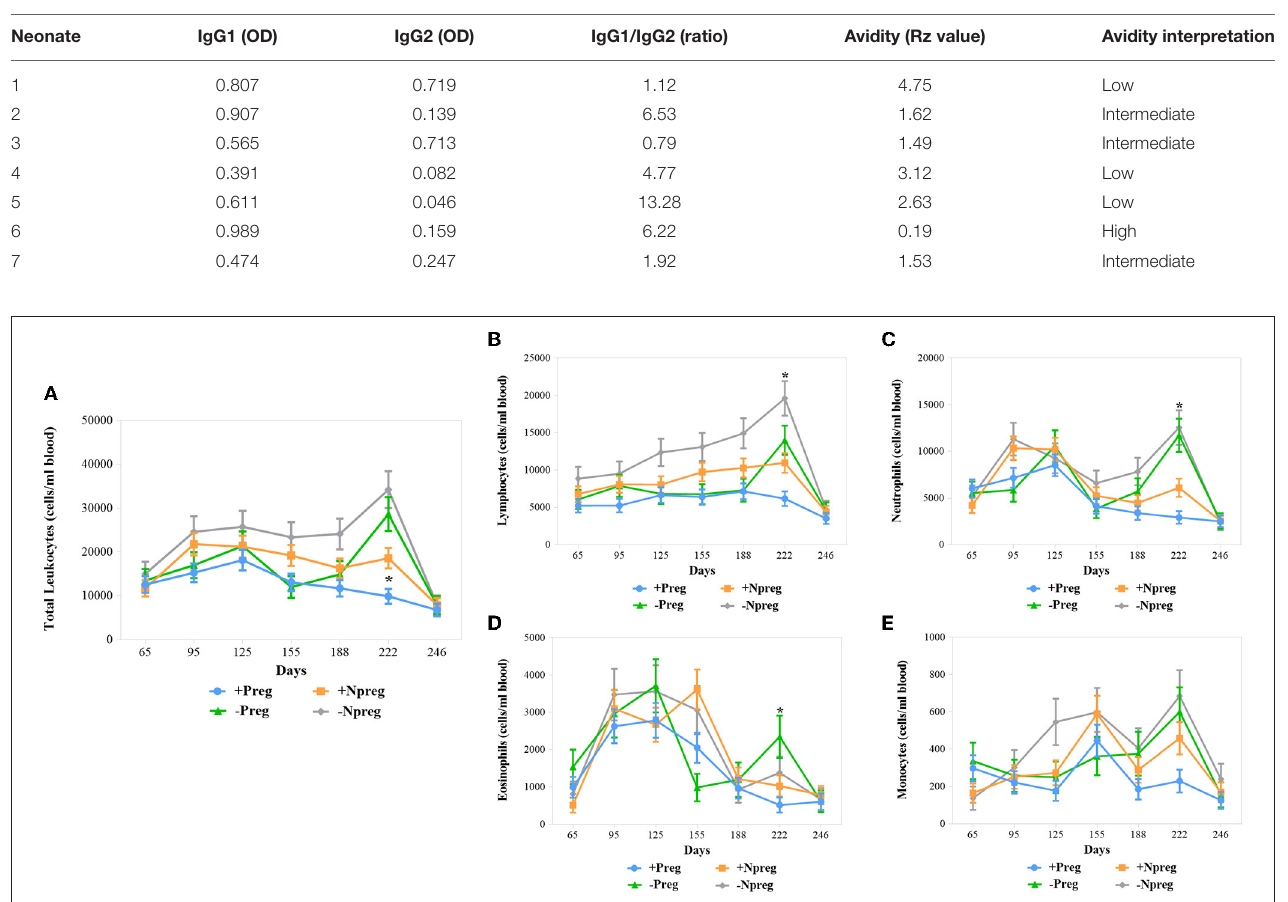
TABLE 1 | Precolostral IgG1, IgG2, IgG1/IgG2 ratio and avidity values in neonates born from Neospora caninum + Preg group.